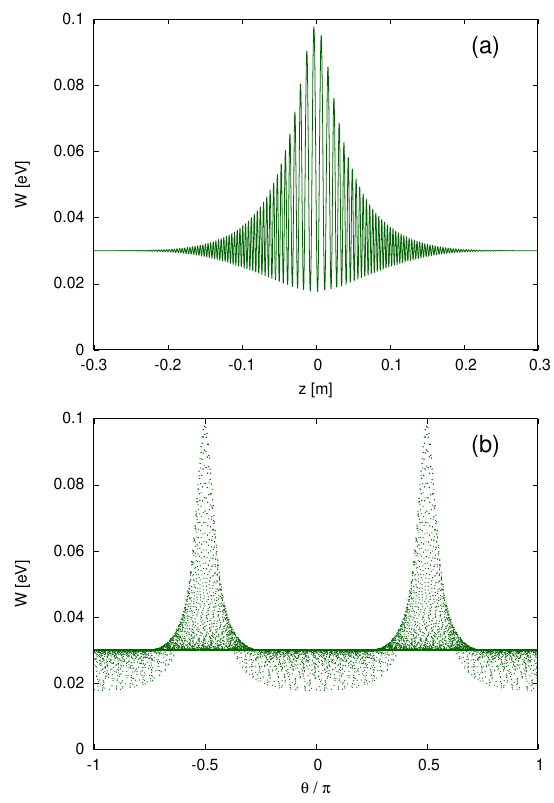
Figure 3. Example of motion for a non trapped particle in the ( W , z ) plane ( (a)), and ( W ,θ ) plane ( (b)). Same parameters as in Figure 1, at lower power P EC = 300 kW.